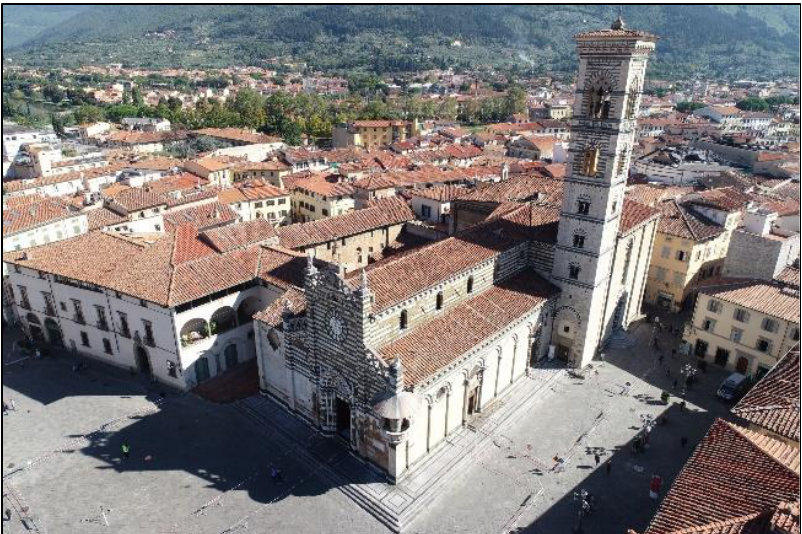
Figure 1. Prato’ s Cathedral and Bell Tower from a drone photo. Figure 1. Prato’s Cathedral and Bell Tower from a drone